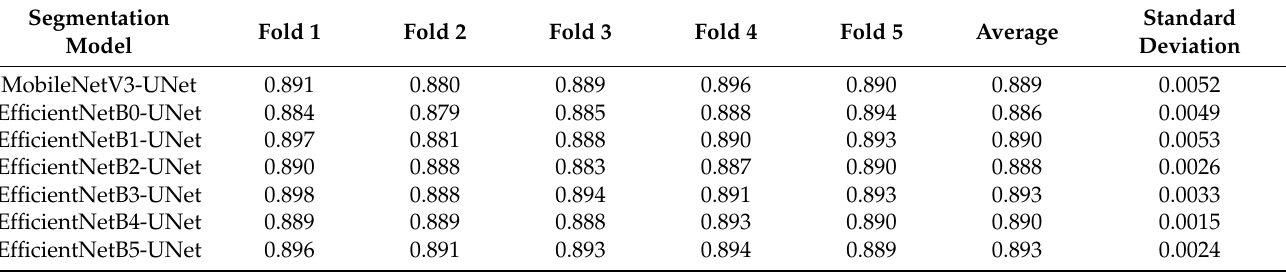
Table 1. Segmentation on the validation set with the Dice